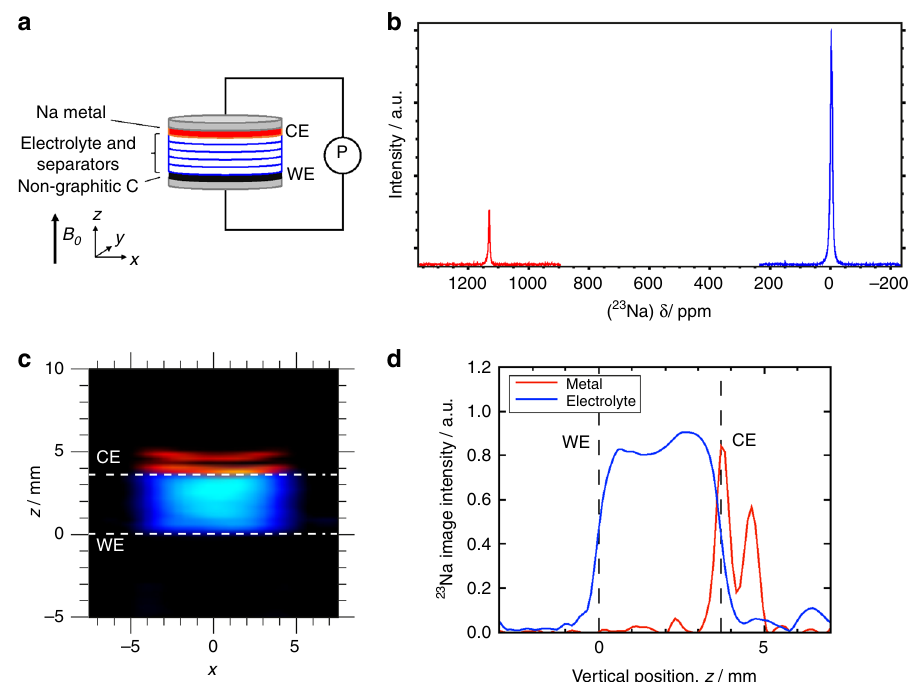
Fig. 1 23 Na NMR signal in a pristine sodium metal cell. a Schematic diagram of the sodium metal cell with respect to the imaging coordinate system and the B 0 magnetic fi eld direction. The working electrode (WE) and counter electrode (CE) are connected to a potentiostat ( P ). b 23 Na NMR spectra, acquired separately, for Na in the dielectric environment of the electrolyte (blue spectrum) and for the metallic Na (red spectrum). c 2D 23 Na MRI of metallic (red) and dielectric (blue) sodium in the cell. The dashed lines indicate the positions of the sodium metal CE and carbon WE. d 1D 23 Na MR pro fi le of metallic (red) and dielectric (blue) sodium in the cell. This cell was assembled with fi ve